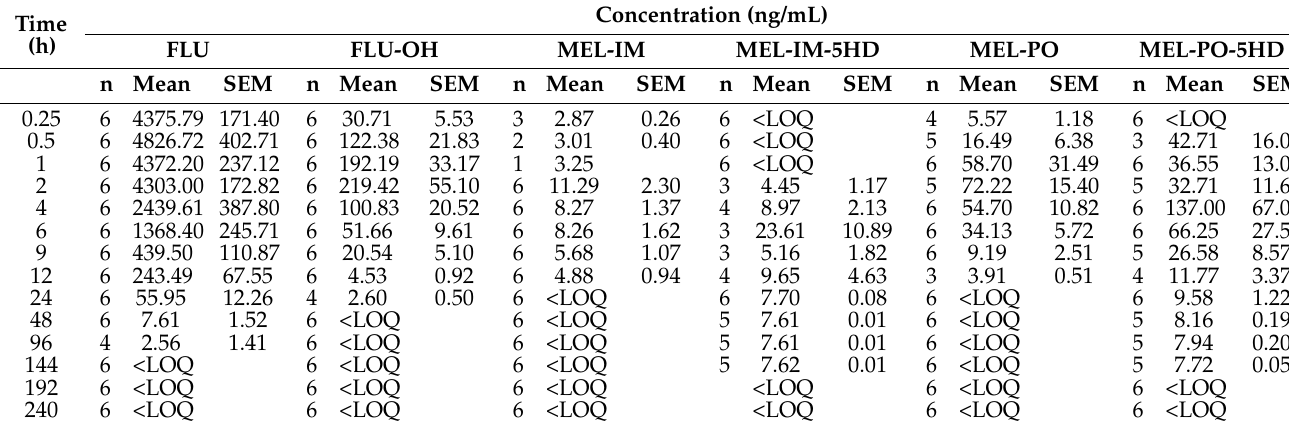
Table 2. Mean ± SEM parent drug and metabolite concentration in plasma after administration of a single dose of flunixin (2.2 mg/kg) intramuscularly or meloxicam (1 mg/kg) intramuscularly or orally (n = 6) in tilapia.